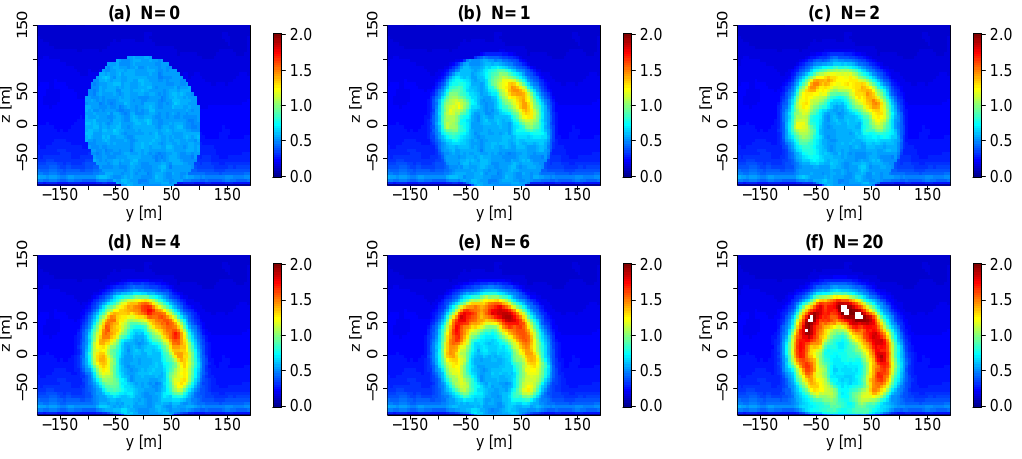
Figure 22. Local SKE (cid:104) u (cid:48) ( y , z ) 2 (cid:105) t ( m 2 s − 2 ) for original LES and the spectral model with added turbulence including different numbers of modes N